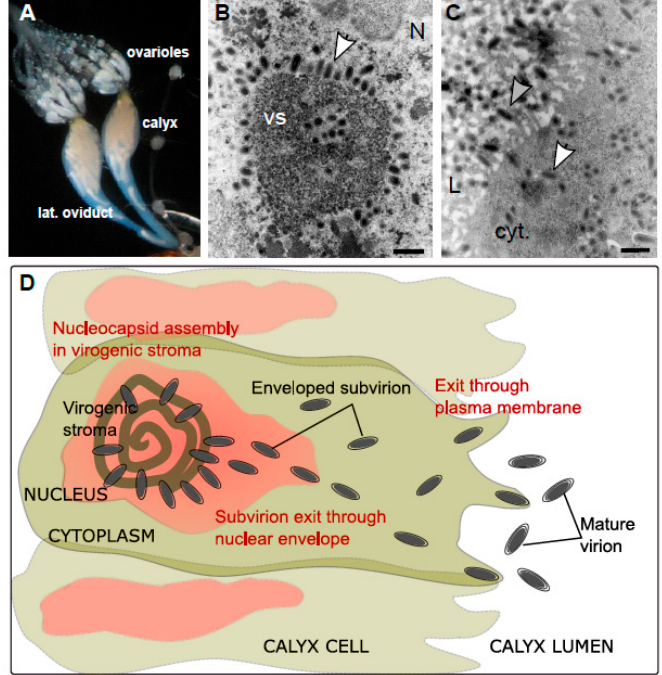
Figure 6. Ichnovirus morphogenesis. ( A ) Light microscopy view of the ovaries of a campoplegine wasp. The calyx region corresponds to the apical part of the lateral oviducts, just below the ovarioles where oogenesis takes place. ( B ) Transmission electron micrograph showing details of a calyx cell nucleus (N). Enveloped virions (arrowhead) are being assembled at the vicinity of the virogenic stroma (VS). Scale bar 500 nm. ( C ) Detail of the cytoplasm (cyt.) of a calyx cell presenting numerous virions (white arrowhead) that bud at the plasma membrane (PM) and accumulate as mature virions surrounded by two envelopes (grey arrowhead) in the calyx lumen (L). Scale bar 500 nm. ( D ) Schematic representation of the different steps of IV particle production in the wasp calyx cells.